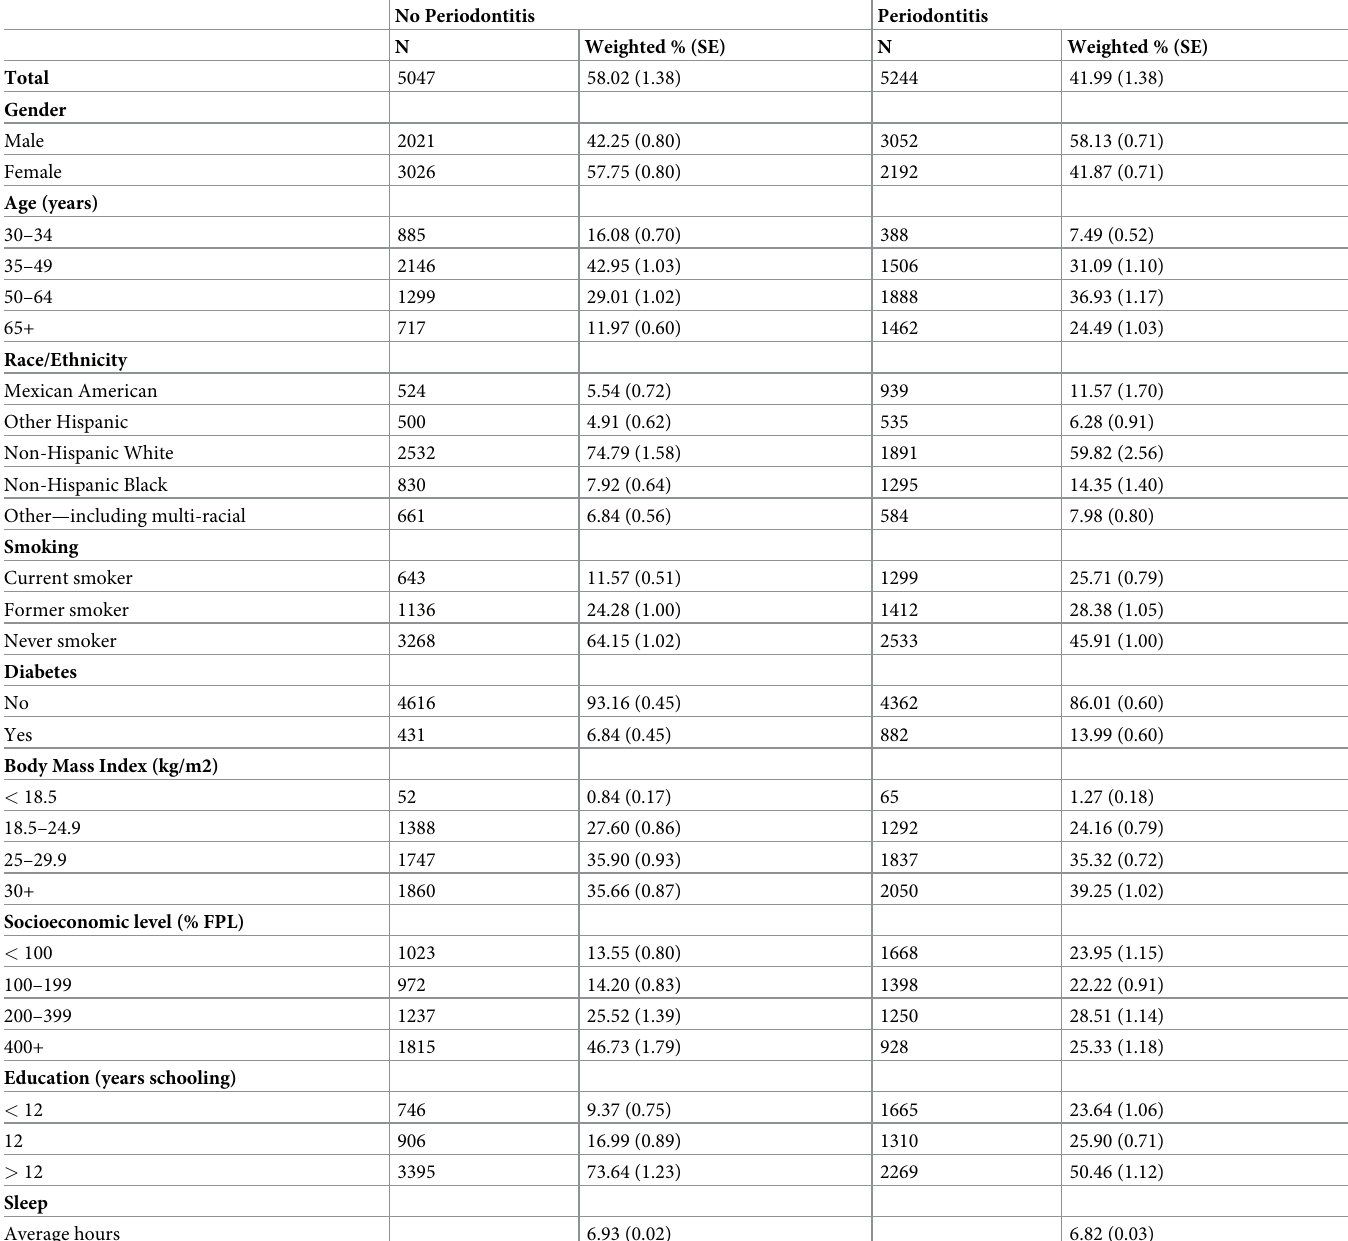
Table 2. Characteristics of the study population by periodontal disease